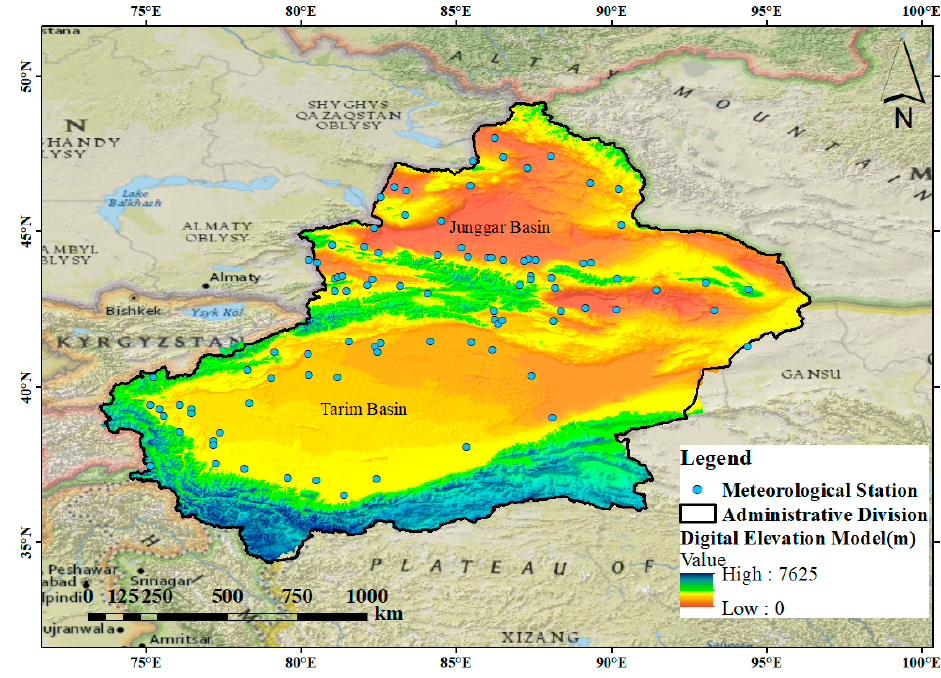
Figure 1. The distribution of the topographic and meteorological stations in the study area.